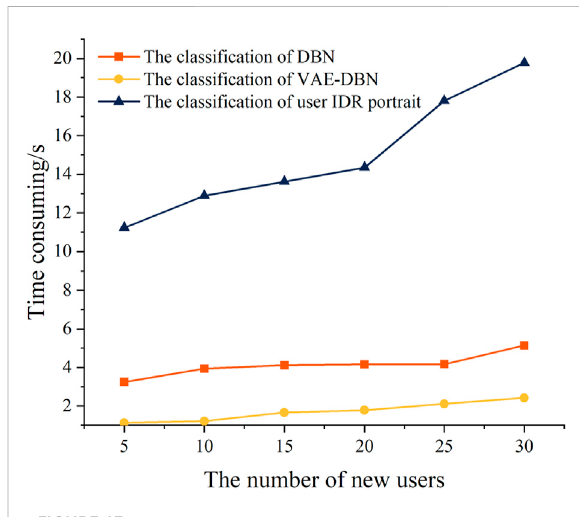
FIGURE 13 The algorithm ef fi ciencies of the portrait and classi fi